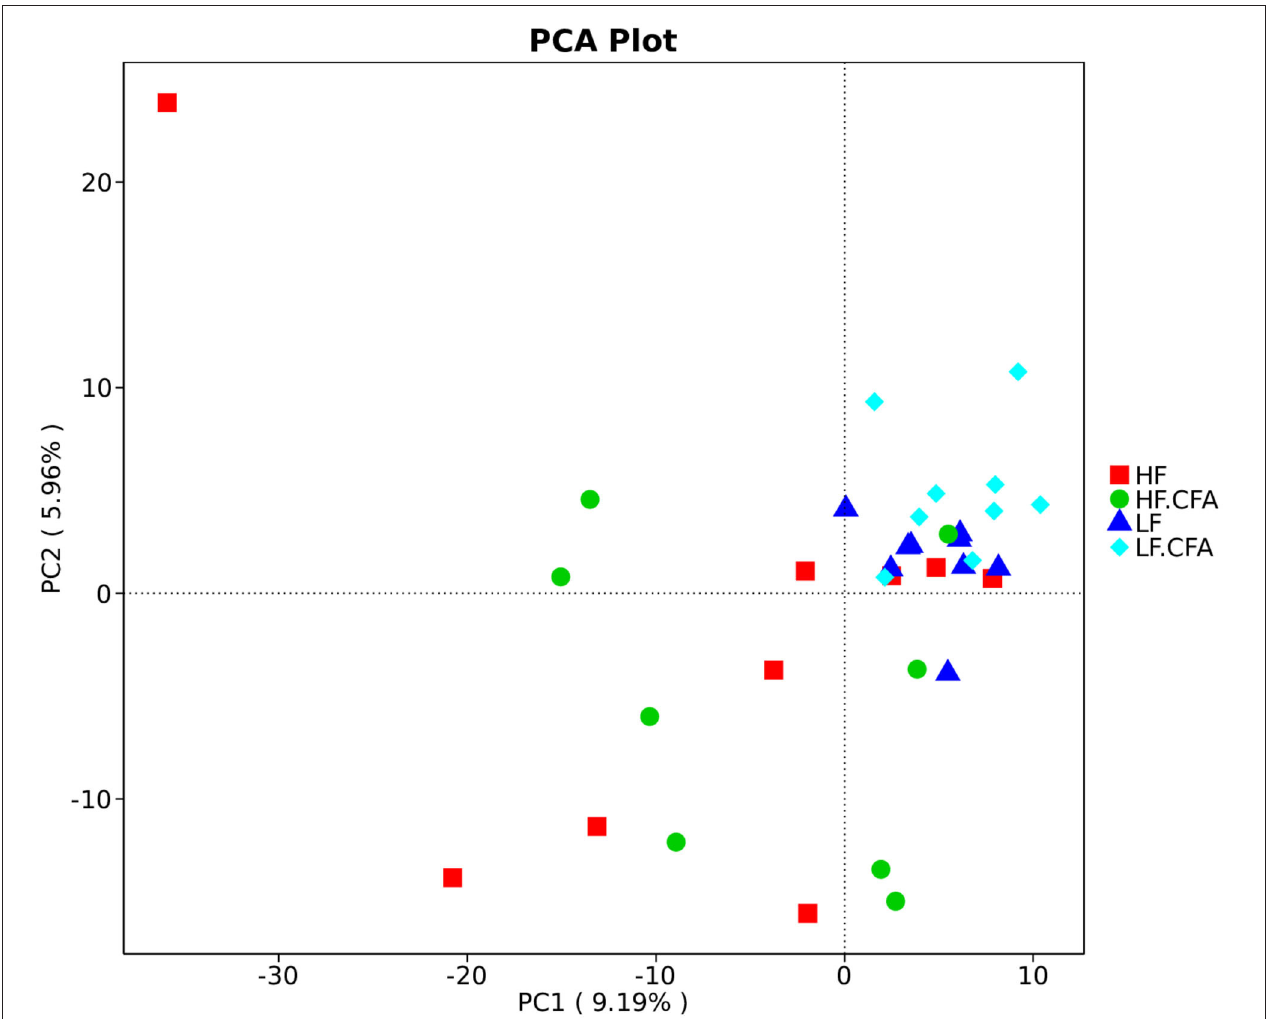
FIGURE 6 | Comparison of the gut microbiota composition among four groups. Principal component analysis to visualize the euclidean distances of colon digesta samples from individual piglet. HF, High fiber, no CFA; LF, Low fiber, no CFA; HF.CFA, High fiber with CFA challenge; LF.CFA, Low fiber with CFA challenge.